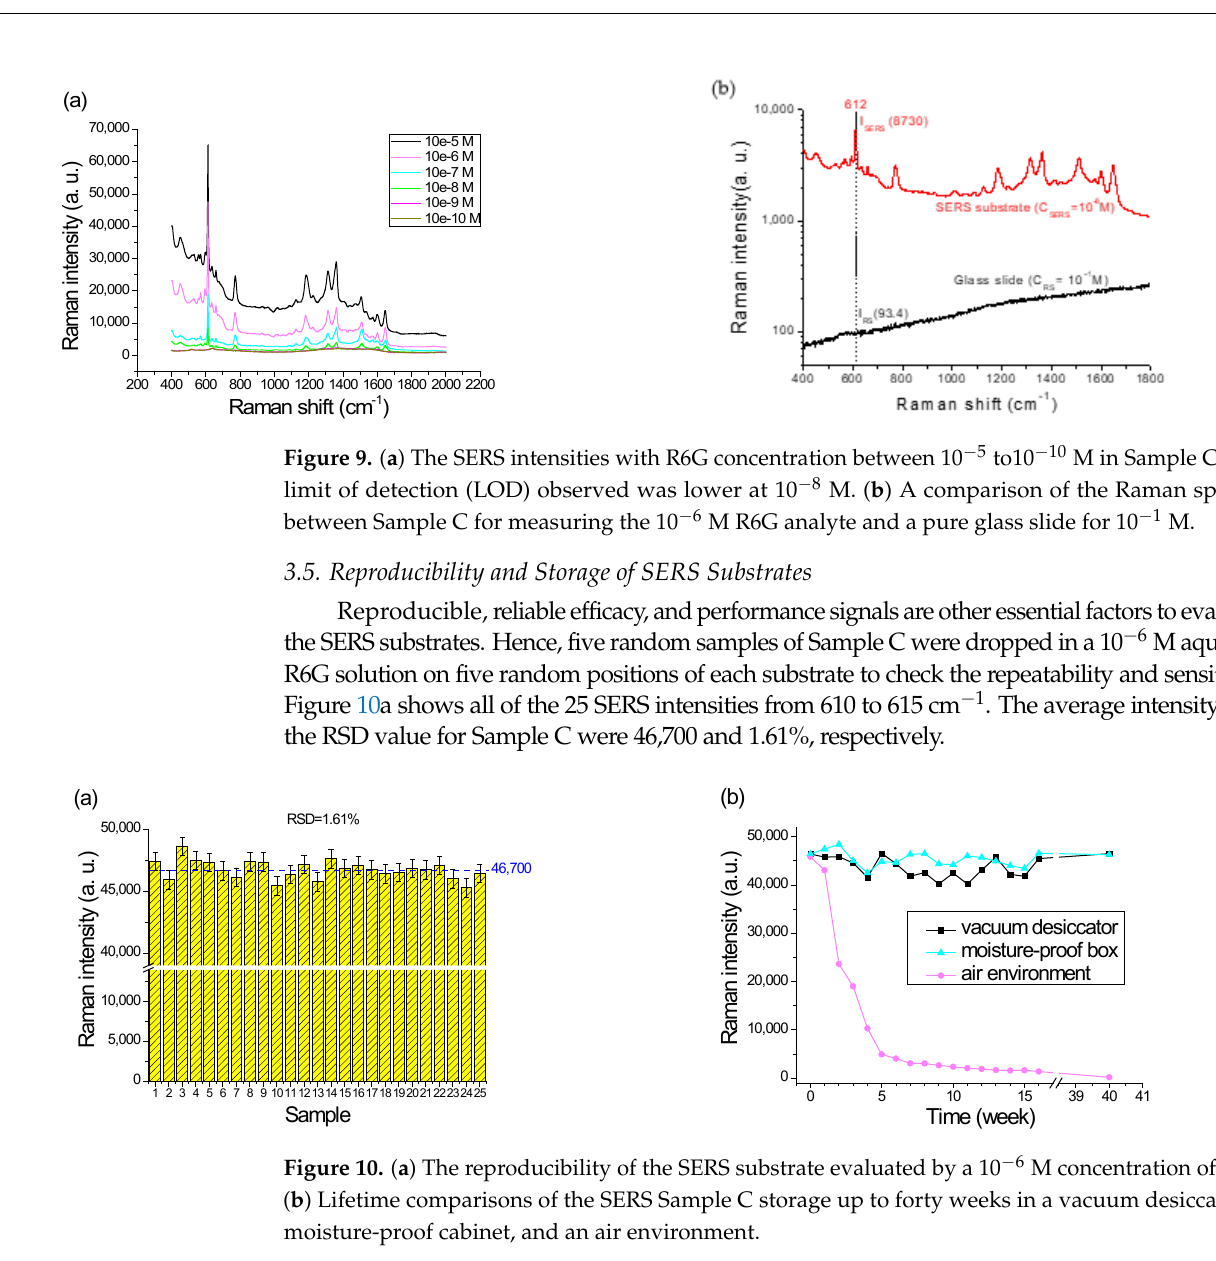
Figure 11. The Raman spectra from the SERS Sample C with various ( a ) paraquat and ( b ) acetylcho- line analyte concentrations.